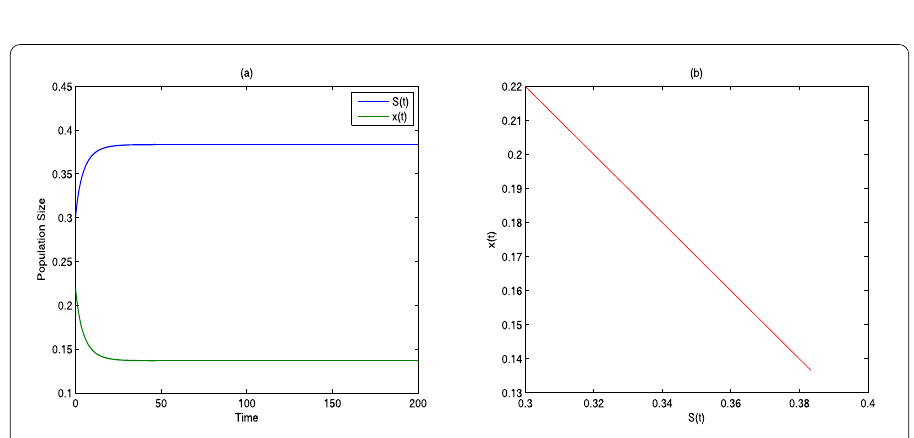
Figure 3 The time series and portrait phase of model (4.2) when α = 0. ( a ) is the time series of S ( t ) and x ( t ); ( b ) is the portrait